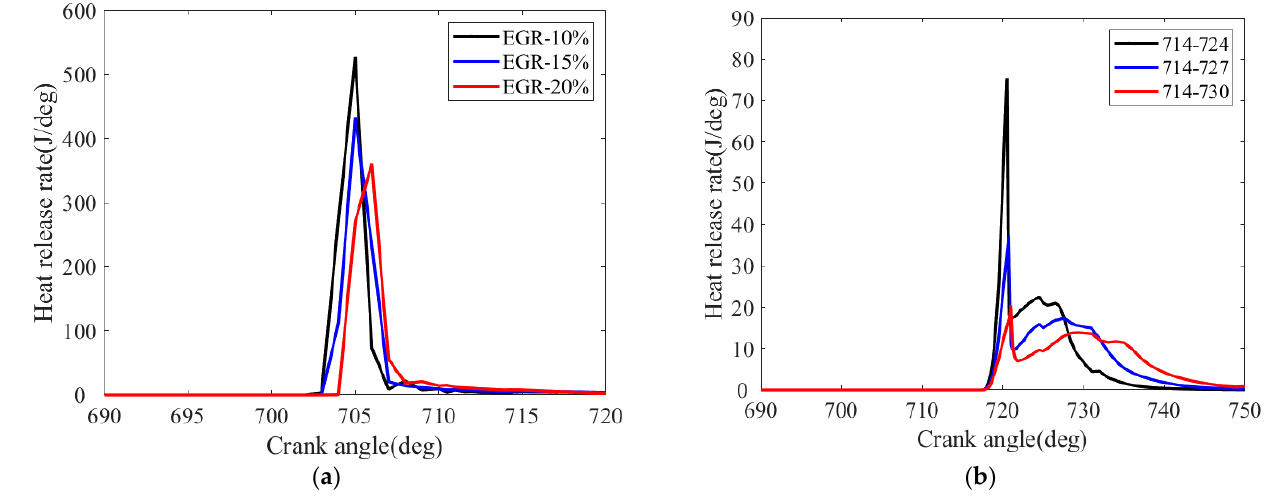
Figure 12. HRR for different EGR rates and injection durations: ( a ) different EGR rates; ( b ) different injection durations.